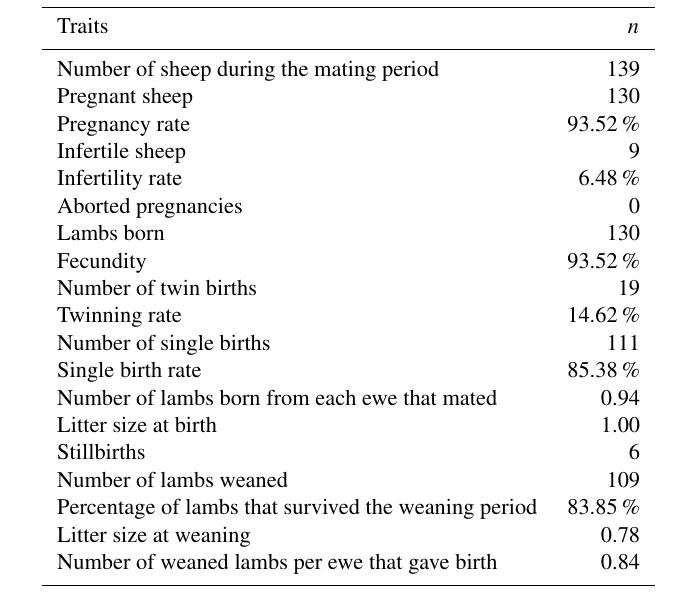
Table 1. Descriptive information on the reproductive traits the Karayaka sheep from this study.